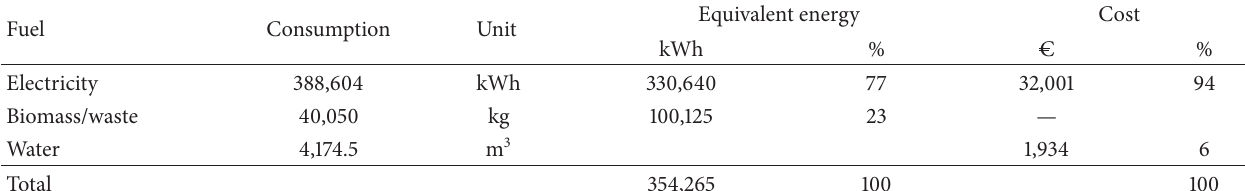
Table 4: Annual balances of energy and water in a wood furniture industry company.